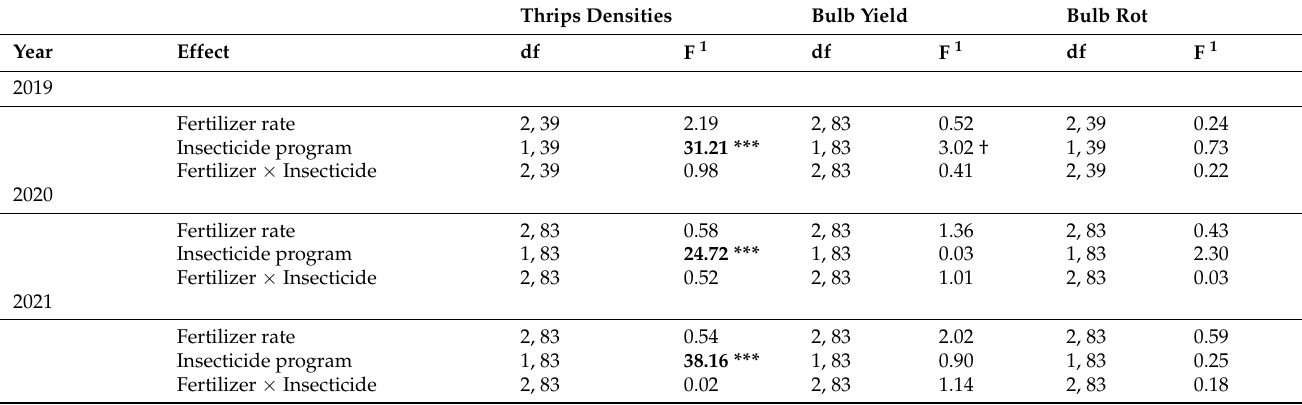
Table 1. Summary ANOVA table for main treatment effects and their effects on Thrips tabaci larval densities, marketable onion bulb yield, and bacterial bulb rot incidence in onion fields in New York (USA) from 2019 through